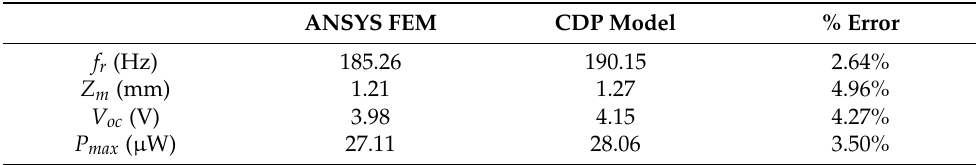
Table 1. Output performance comparisons of the trapezoidal beam PVEH by using the ANSYS FEM and the constructed bidirectional coupled DP